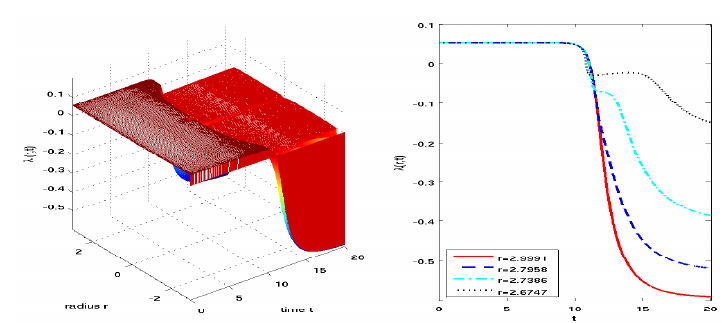
Figure 1. The coefficient λ ( r,t ) for three different cases a ) − c )